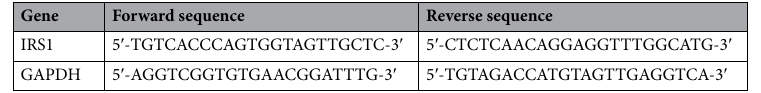
(Table 2, Fig. 1, and Supplementary 6). On the other hand, adding a combination of vitamin C/cimetidine to the culture medium of the MCF7 cell line resulted in a 3.42-fold reduction of IC50 (42.16 μmol/L) compared to the cimetidine treated medium.